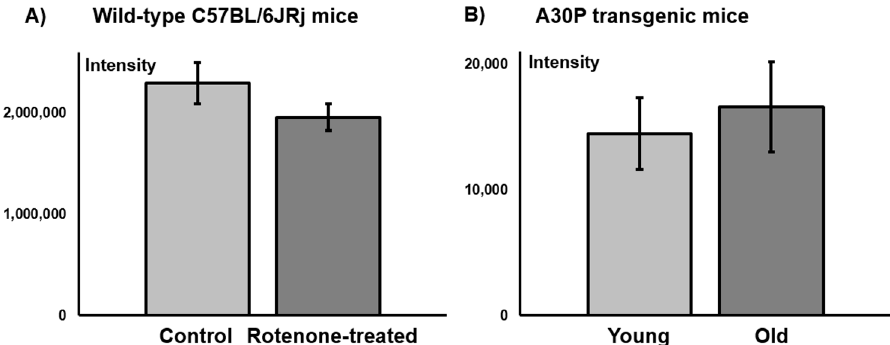
Figure 7. Mean fluorescence intensity of A 2A R staining on the striatum of coronal C57BL/6JRj mouse brain sections: ( A ) Control vs. rotenone-treated wild-type mice (n = 3, respectively); ( B ) Young (39 weeks) vs. old (71–76 weeks) A30P transgenic mice (n = 3, respectively).